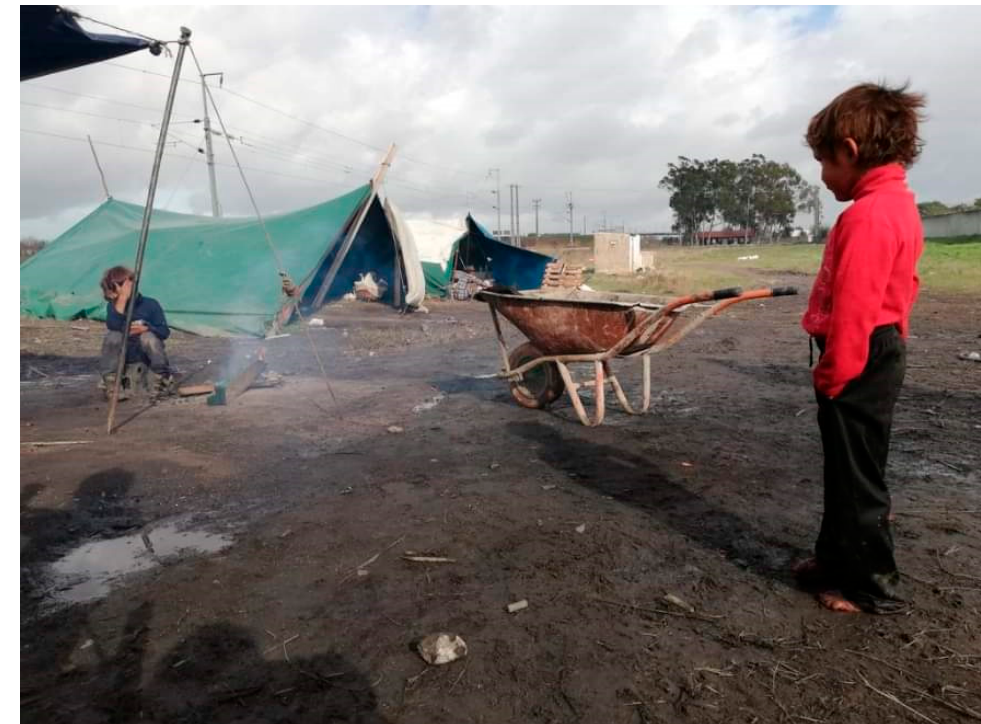
Figure 2. Cigano Camp. Photograph by Fernando Moital. January 2022.